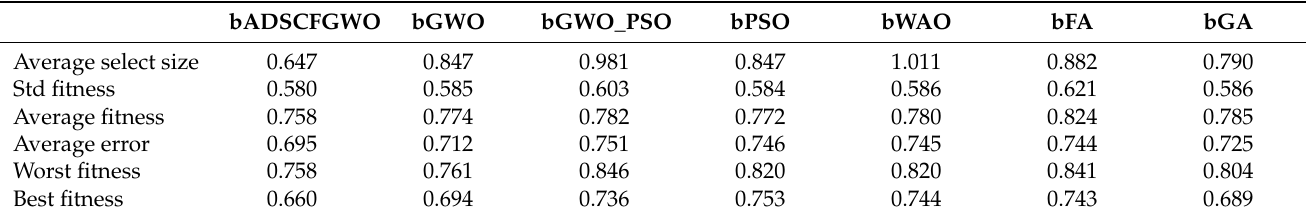
Table 7. Evaluation of the proposed feature selection method and three other competing methods.